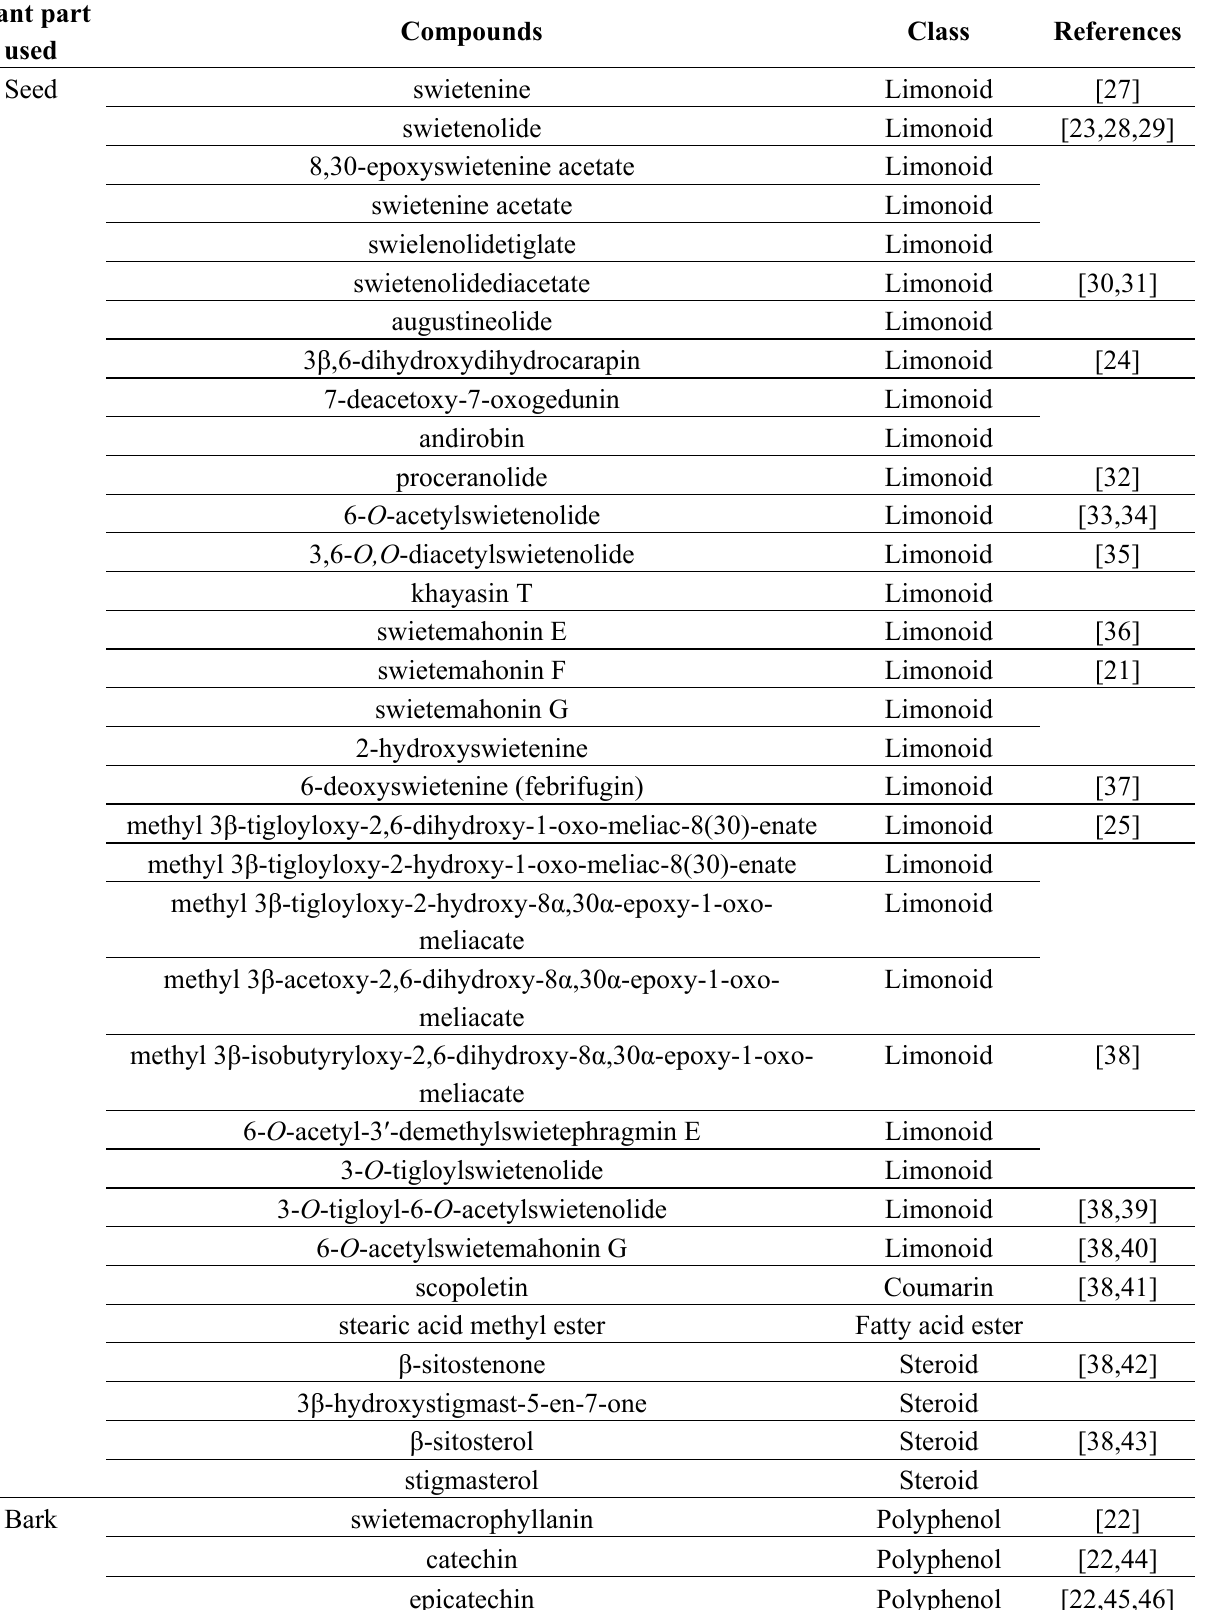
Table 1. Compounds isolated from Swietenia macrophylla